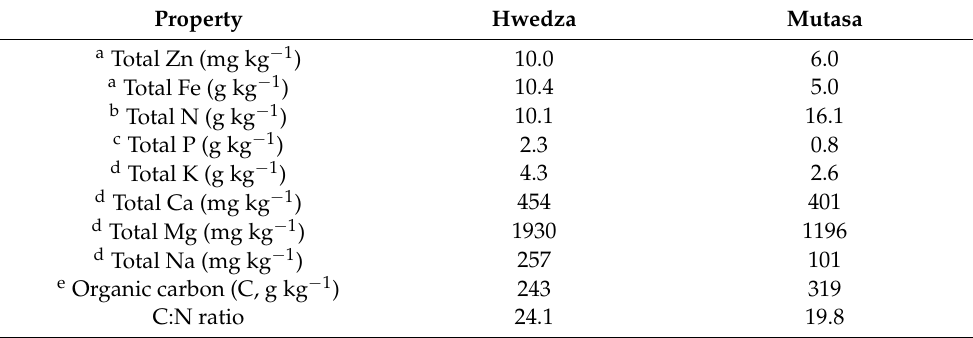
Table 4. Nutrient composition of cattle manure used for field experimentation ¥